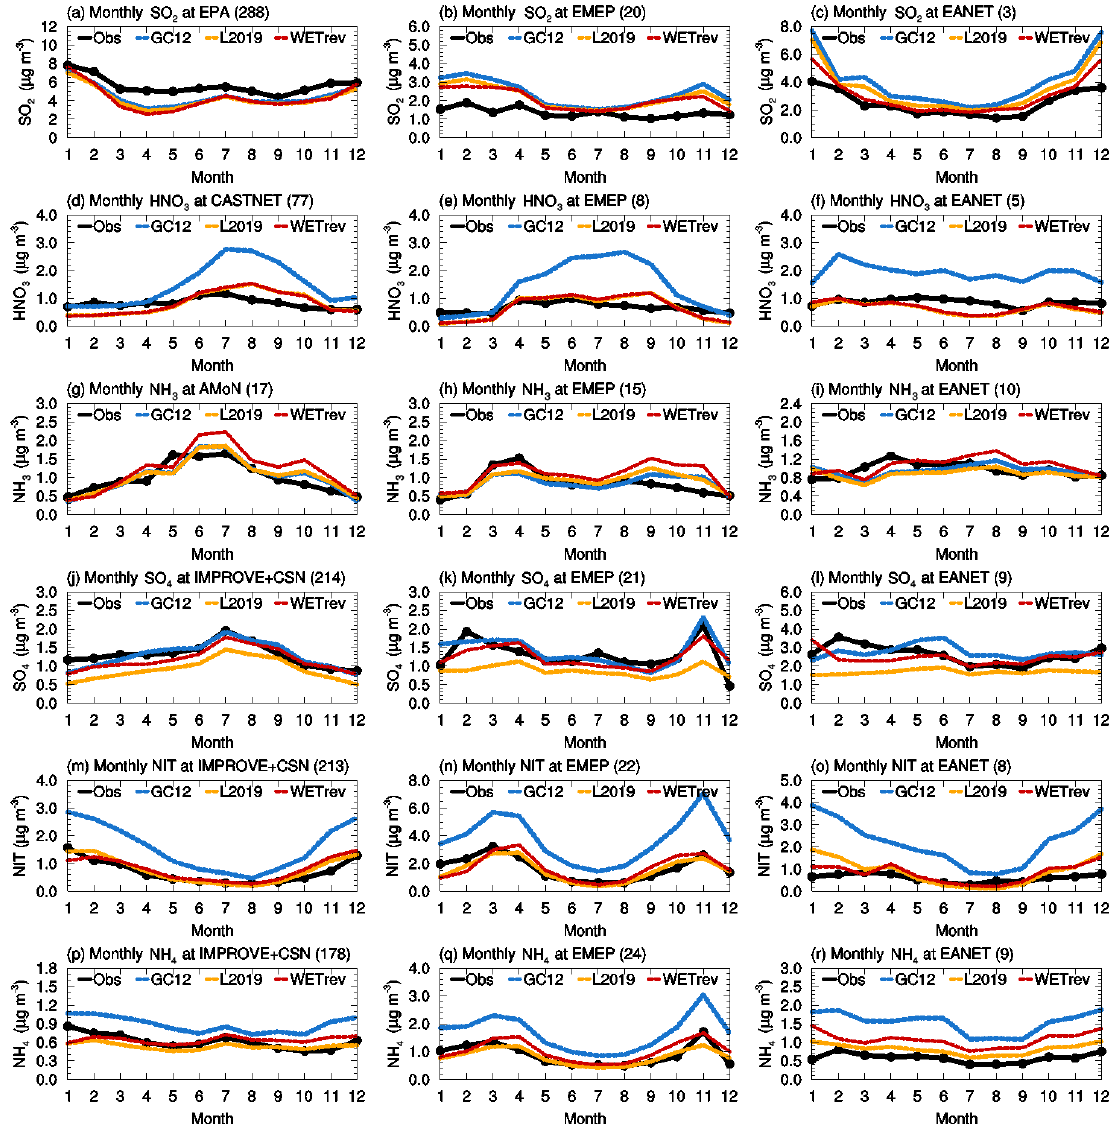
Figure 1. Variations of monthly means for the year 2011 showing the comparisons of SO 2 , nitric acid, ammonia, sulfate, nitrate, and ammonium surface mass concentrations which are observed over (left column) the US, (center column) European, and (right column) Asian sites (black) and simulated by GC12 (blue), L2019 (yellow), and WETrev (red)